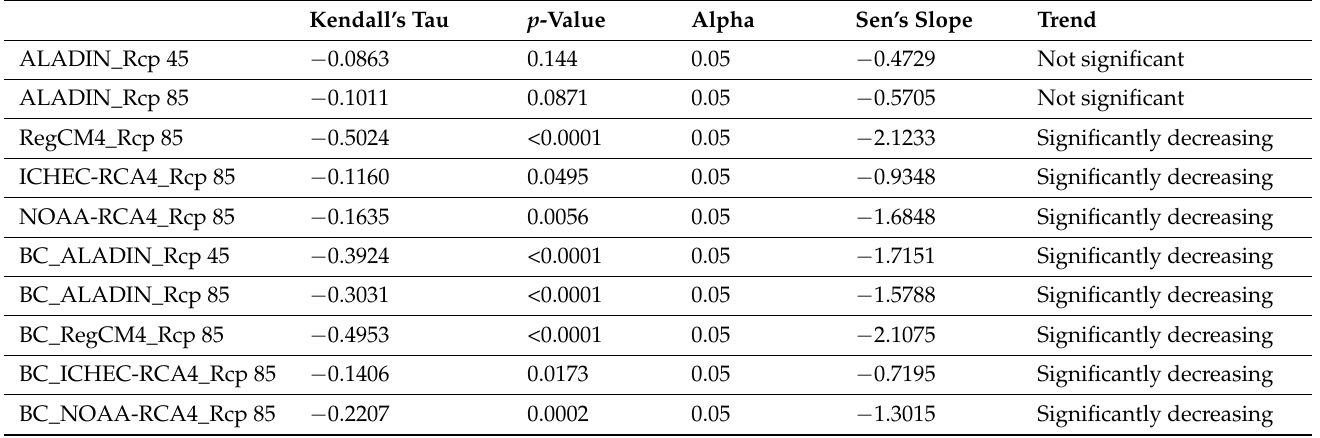
Table 3. Mann–Kendall trend test for future annual precipitation RCPs 4.5 and 8.5 scenarios for RCMs before and after the bias correction.